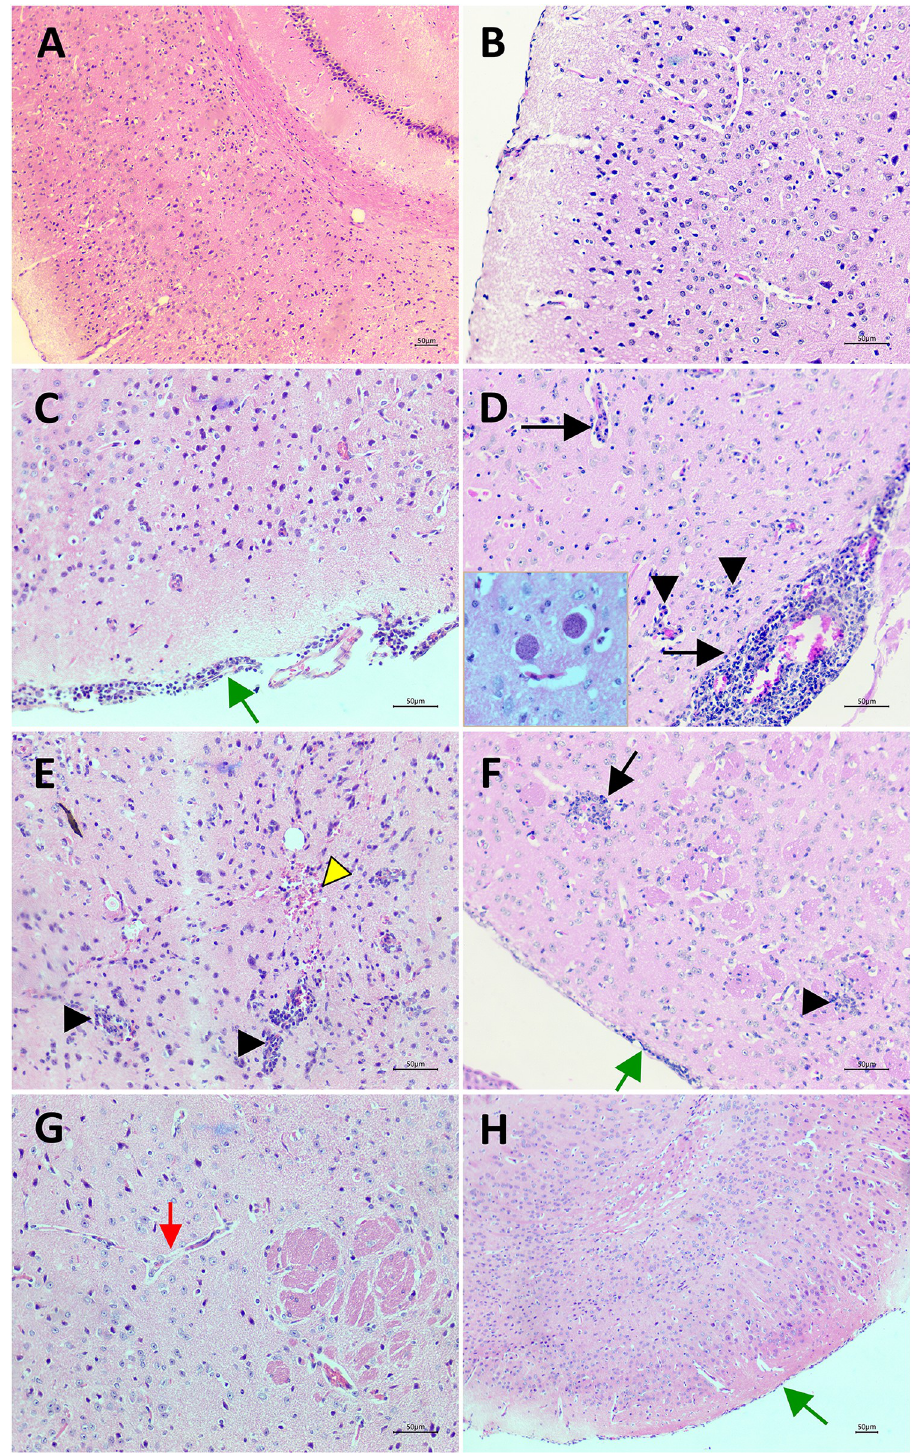
Fig 4. Histopatological analysis of brain tissue. (A—B) Normal structure of cortex from control group (non- infected). (C—E) Infected with T . gondii ME-49 strain, treated with vehicle group (infected control group). Meningitis (green arrow), perivascular cuffs (arrow), lymphocytes and microglial nodules (arrow head), hemorrhage (yellow arrow head). In detail, Toxoplasma gondii cysts. (F—G) Infected group treated with rosuvastatin 40mg/Kg. Discrete inflammatory cell infiltration and microglial proliferation with gliosis areas, indicating old tissue injury. Meninges